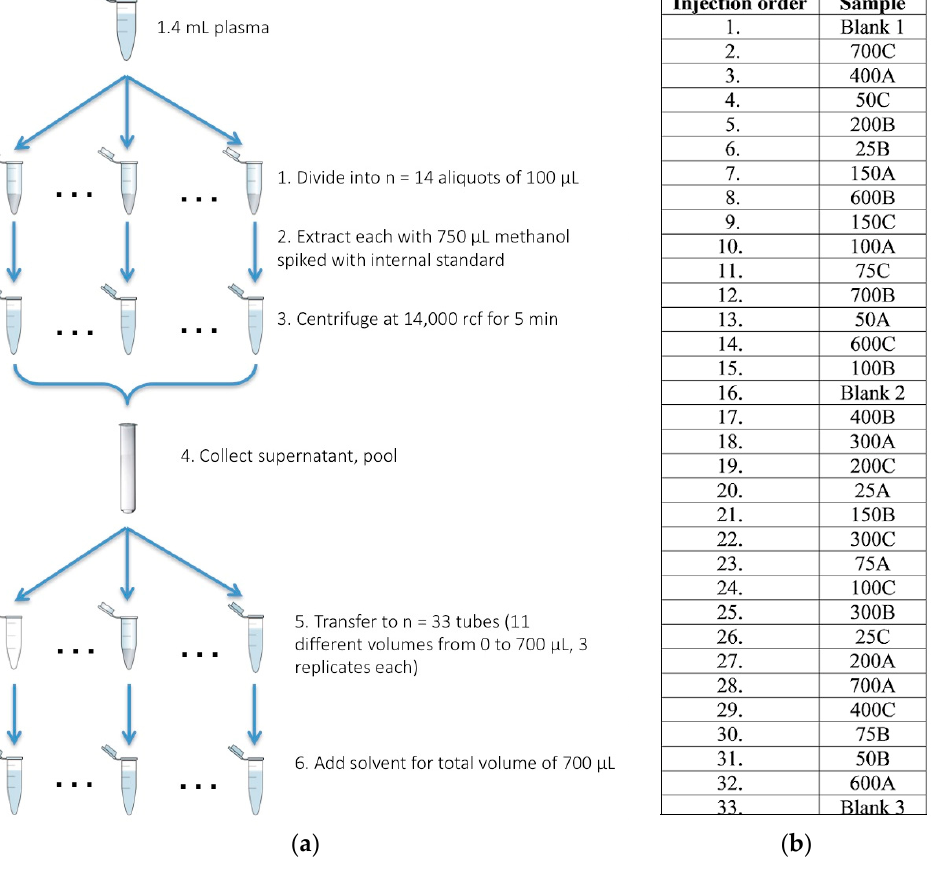
Figure 5. ( a ) Schematic of the sample preparation steps for the limiting dilution study; ( b ) an example of the injection order of the plasma extract aliquots. Aliquots were analysed in a randomized order to minimize biases in sample preparation and data acquisition. Blanks containing the reagents only were included in at the beginning, middle, and end of each run. The concentration-specific study used a similar protocol except for different plasma extract volumes (0, 150 and 700 µL only).